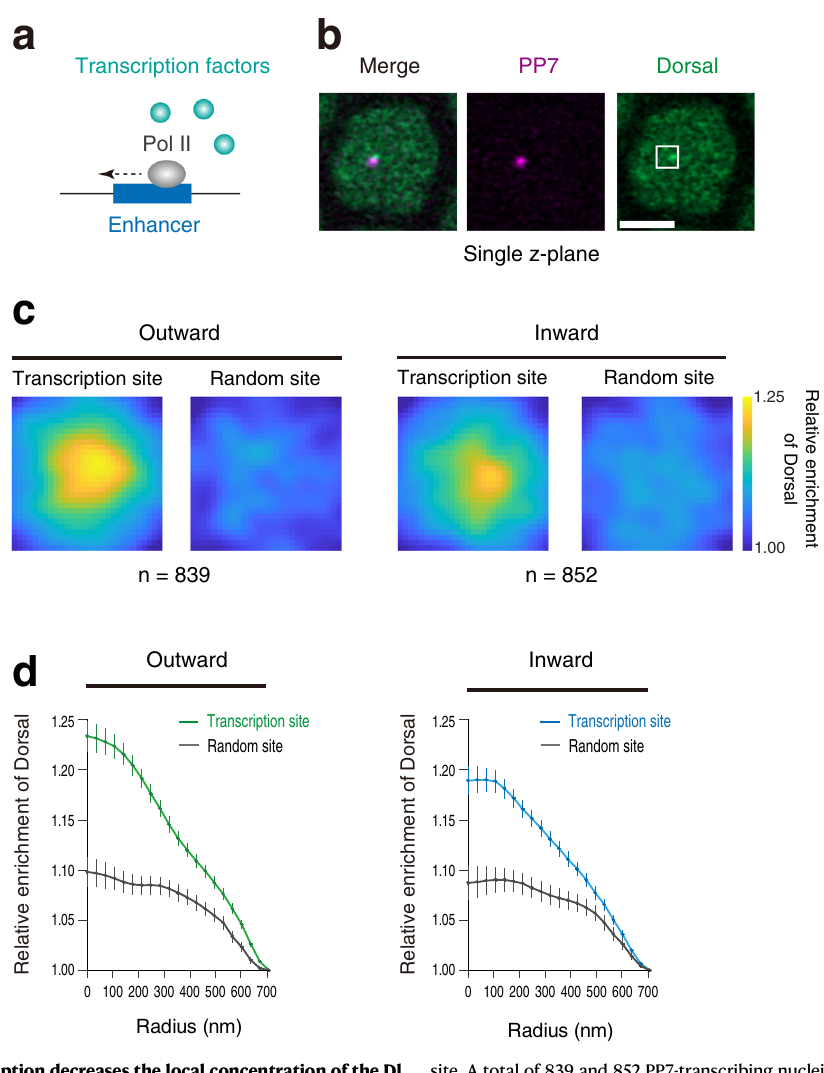
site. A total of 839 and 852 PP7-transcribing nuclei, respectively, were obtained from50independentembryosforthereporterlocusdrivingPP7transcriptioninan outward (left) or an inward orientation (right). d Radial pro fi les of the averaged Dorsal-GFPdistributionareshownin( c ).Errorbarrepresentsthestandarderrorof the mean. The difference between the areas of distribution curves of the tran- scription site was tested by a two-sided Wilcoxon rank-sum test ( p =0.02). Source data are provided as a Source Data fi